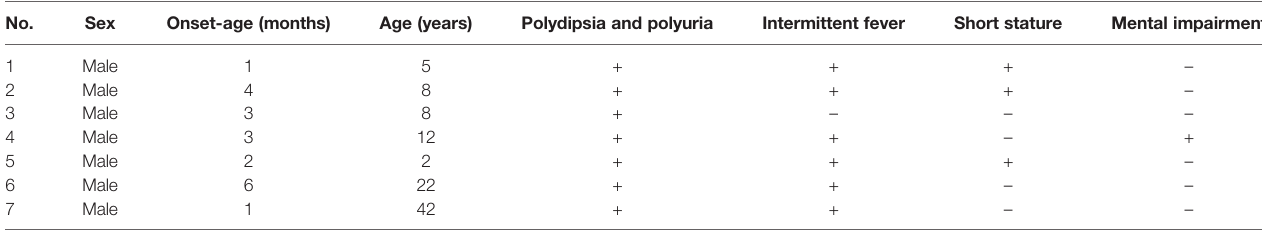
TABLE 2 | Clinical characteristics in patients with